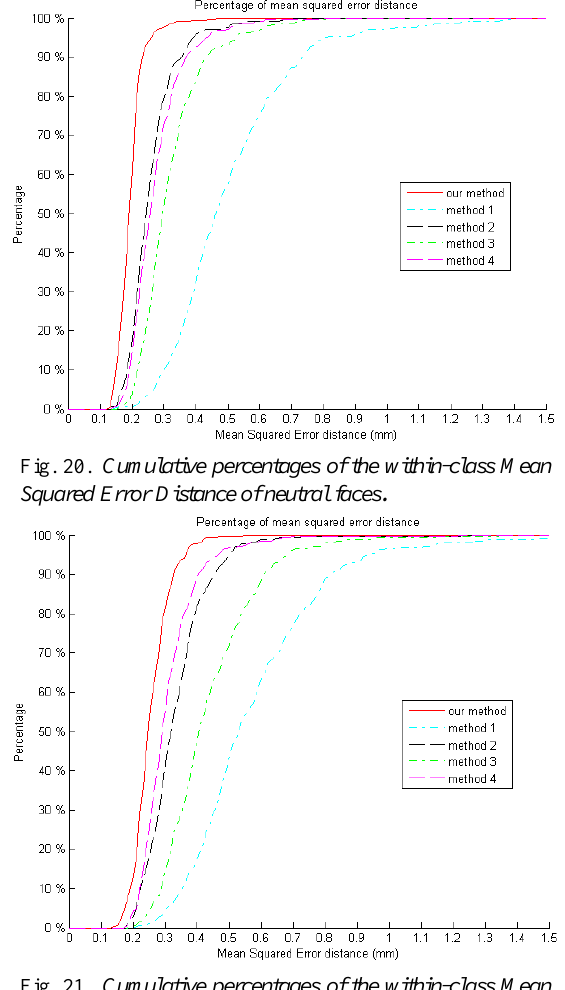
Fig. 21. Cumulative percentages of the within-class Mean Squared Error Distance of non-neutral